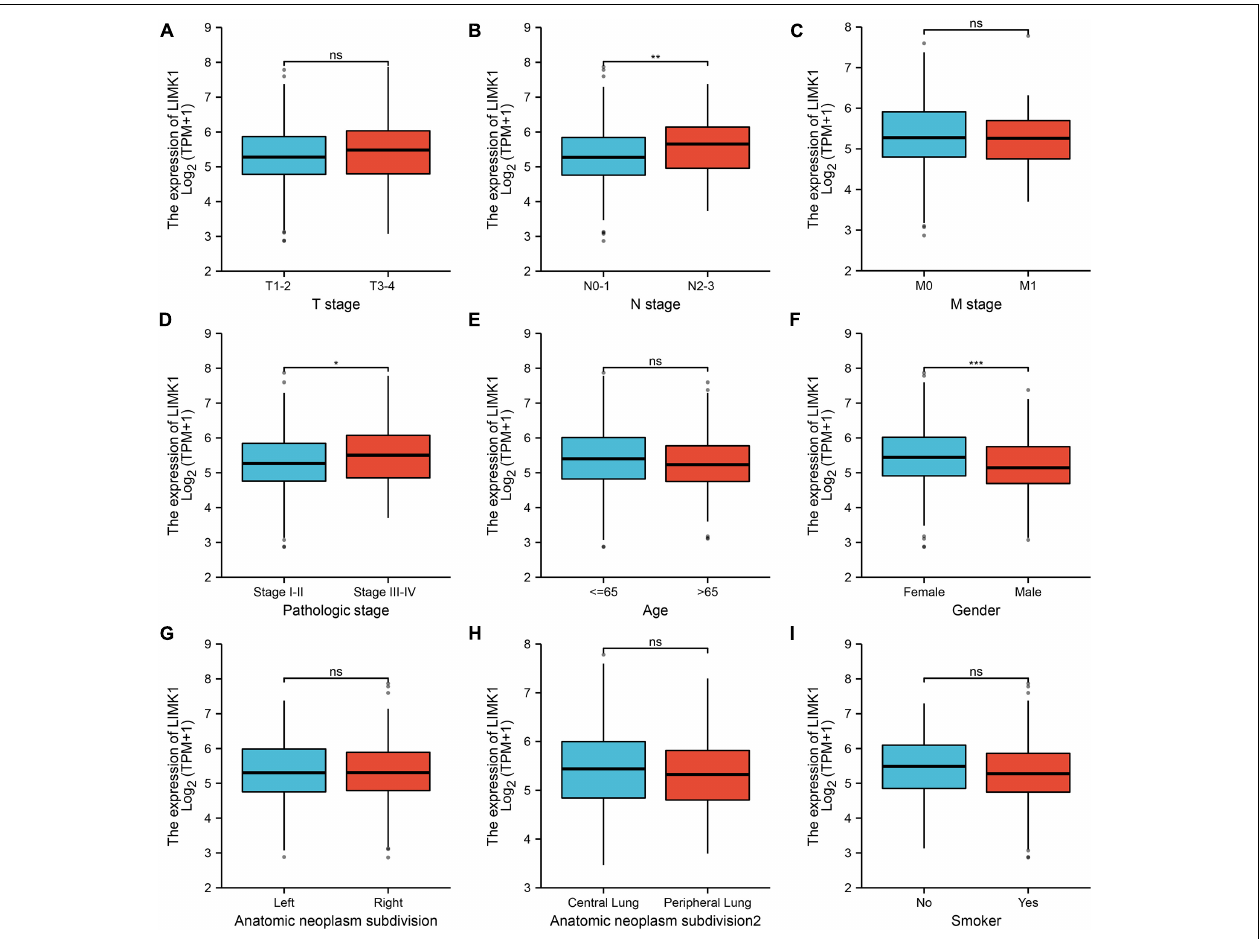
FIGURE 3 | Relationships between LIMK1 mRNA levels and clinical pathological characteristics. LIMK1 mRNA expression was significantly correlated with lymph node metastases (B) , high TNM stage (D) and gender was male (F) . However, no statistically significant correlation were found between the expression levels of LIMK1 and T stage (A) , M stage (C) , age (E) , anatomic neoplasm subdivision (G,H) and smoke condition (I) (ns, no significance, * P < 0.05, ** P < 0.01, *** P < 0.001).